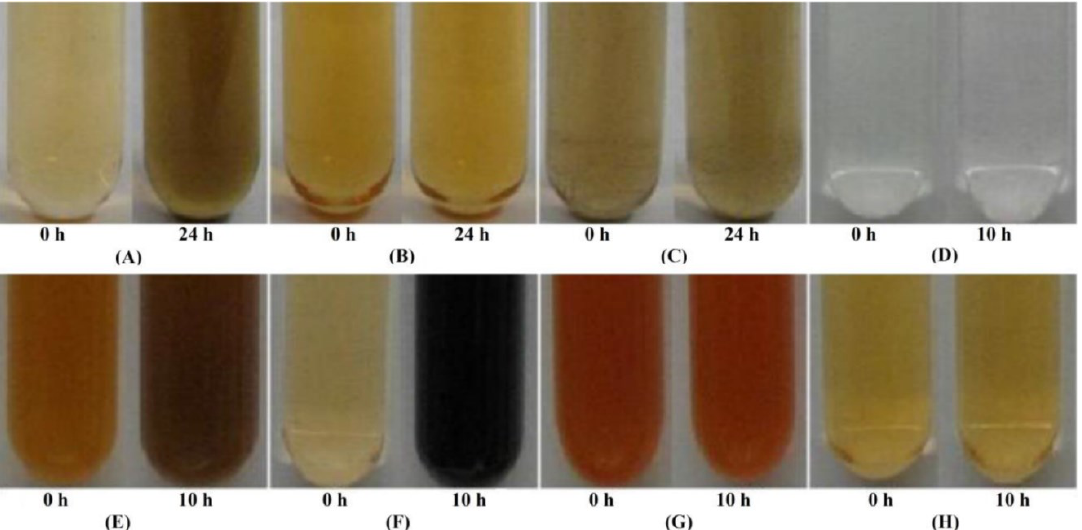
Figure 3. Reductase activity in cellular fractions. ( A ) Cell lysate of strain E1 grown without prior exposure to K 2 TeO 3 . Similar results were found for KR99, E5, RB3, and RB 16-17; ( B ) Lysate of strain E4(1) grown without prior exposure to K 2 TeO 3 ; ( C ) Lysate of E4(1) cells grown with prior exposure to K 2 TeO 3 . Initial darkening at 0 h is due to the trace presence of previously reduced K 2 TeO 3 from prior exposure; ( D ) Periplasmic fraction of KR99 without K 2 TeO 3 exposure. No reductase activity observed. Similar results for E5, E4(1), E1, RB3 and RB 16-17; ( E ) Spheroplast fraction of E1 without prior K 2 TeO